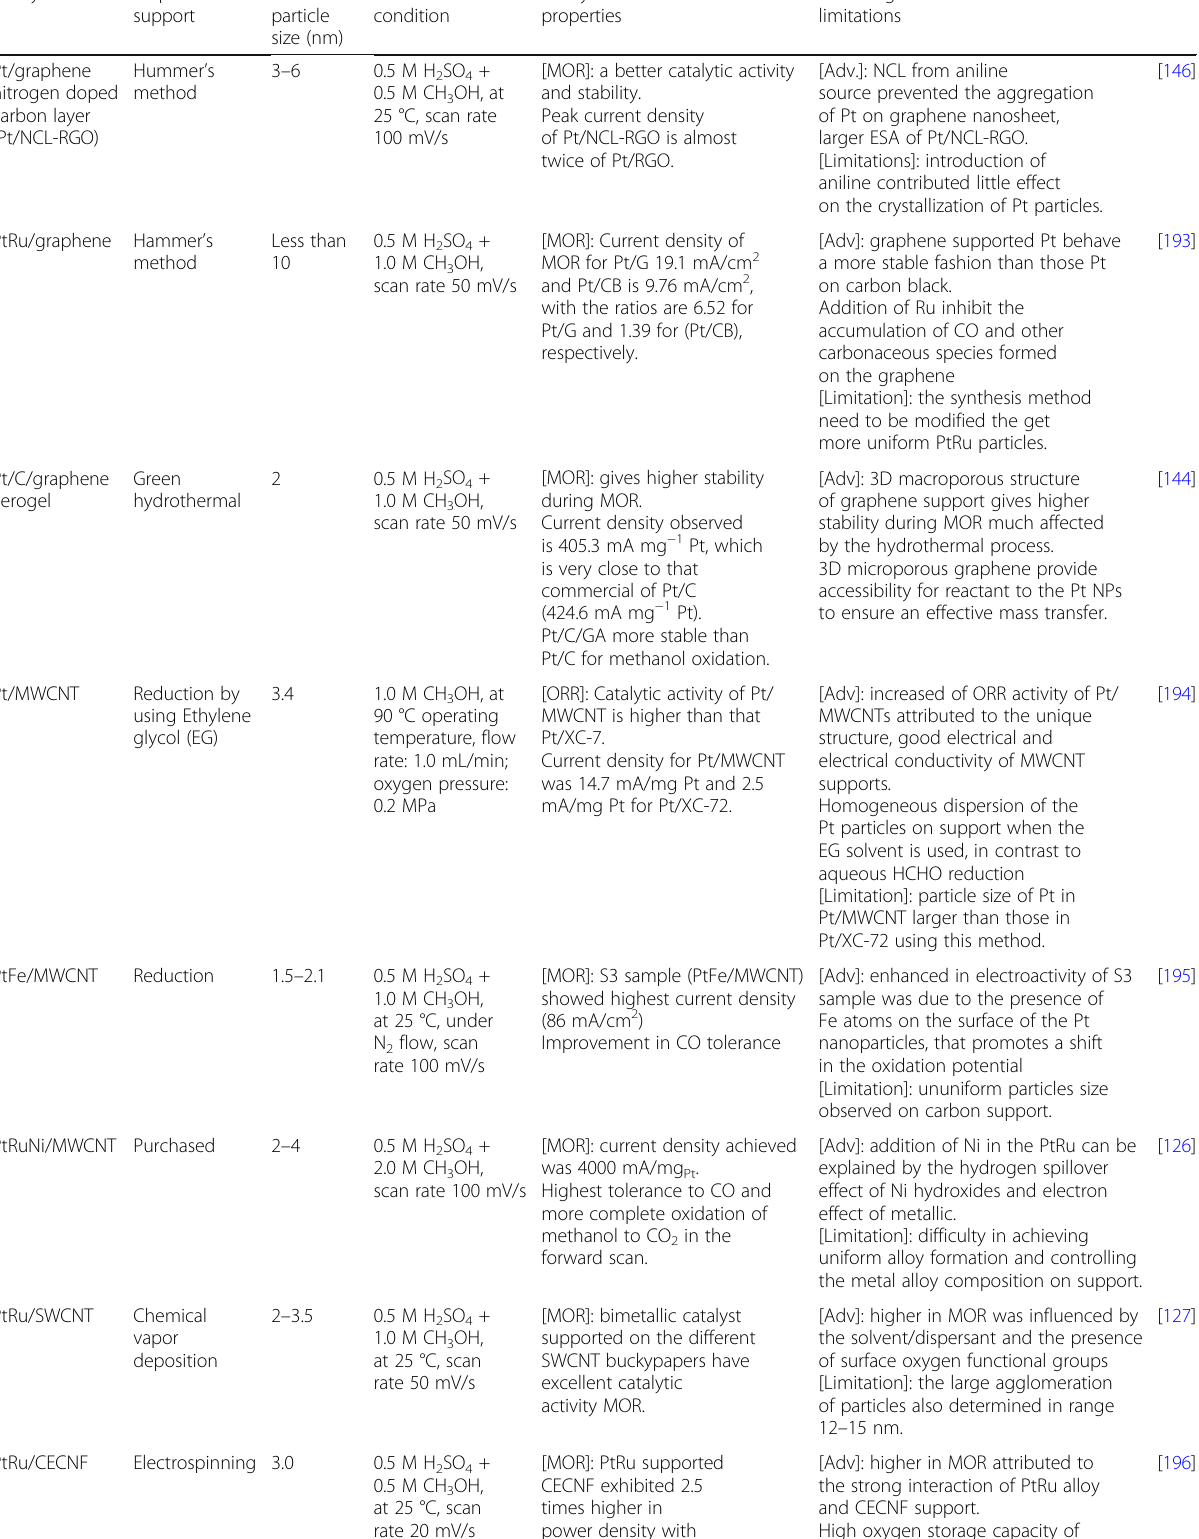
Table 2 summarize the preparation, physical properties, performance, and activity of Pt-based supported various carbon materials